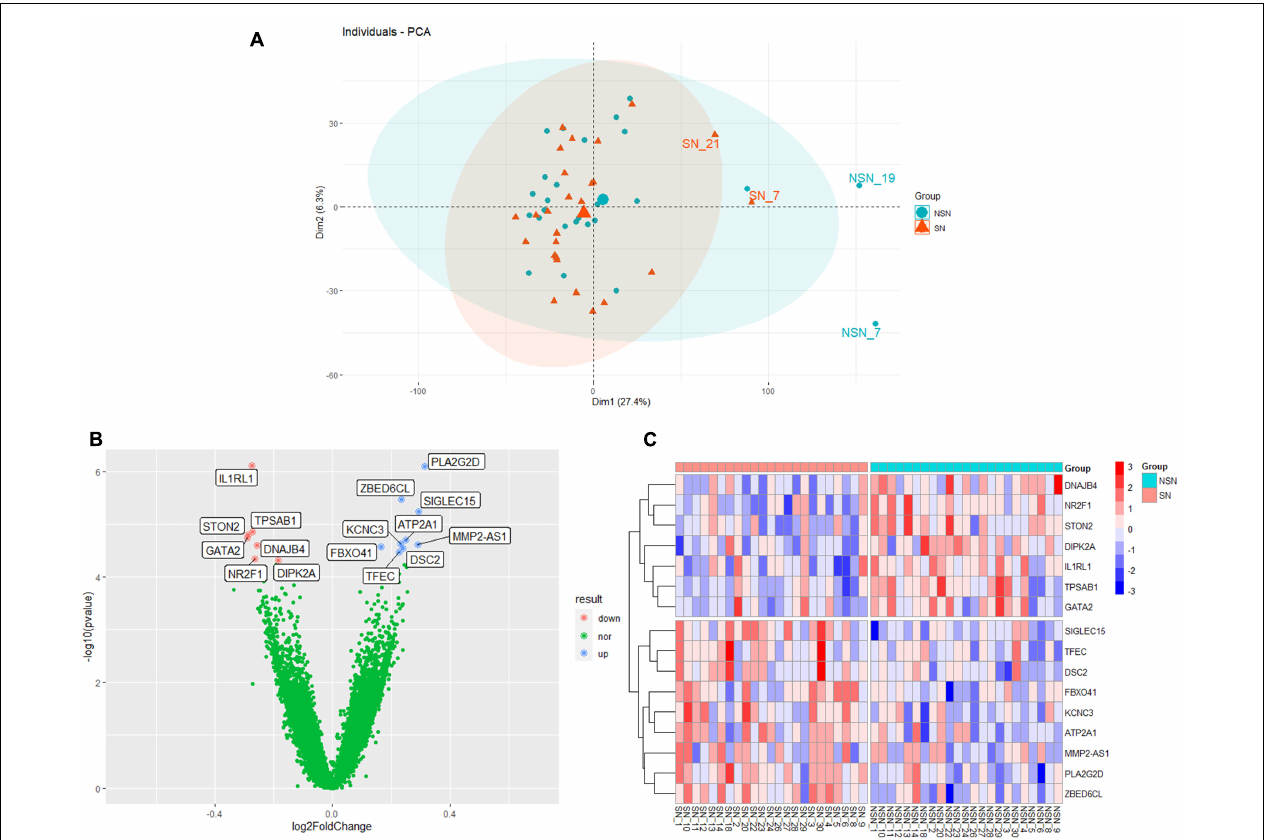
FIGURE 1 | Differential gene expression profiles. (A) Principal component analysis (PCA) plot of individual sample. (B) Volcano plot of differentially expressed genes (DEGs). (C) Clustering heat map of differential gene expression.